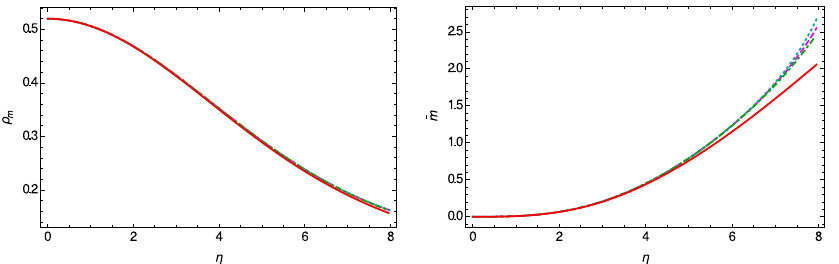
Fig. 18 Variation of the energy density ¯ ρ m (left panel) and of the inte- rior mass profile ¯ m (right panel) for three-form field quark stars in the presence of a Higgs-type potential as functions of η , for ¯ a = 0 . 01, and for three different values of the constant ¯ b : ¯ b = 0 (dashed curve), ¯ b = − 0 . 11 (dotted curve), and ¯ b = 0 . 11 (dot-dashed curve). The cen-